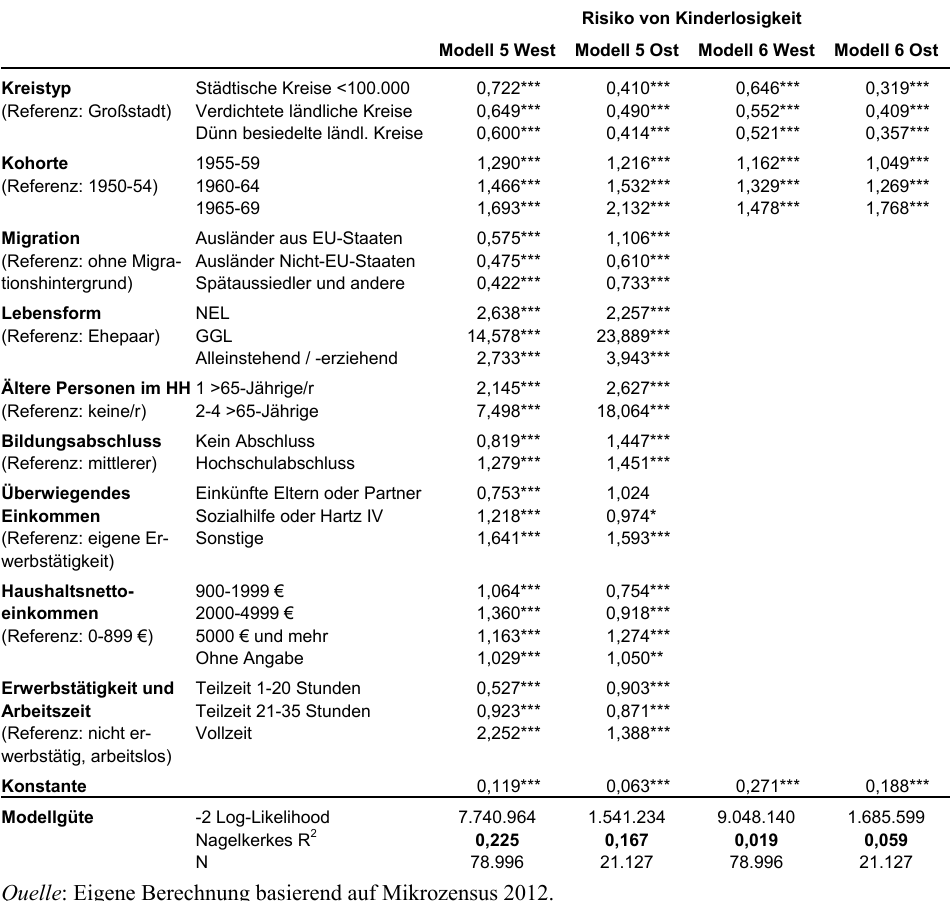
Tabelle 3 : Logistische Regression, Odds Ratios, Vergleich Ost- und